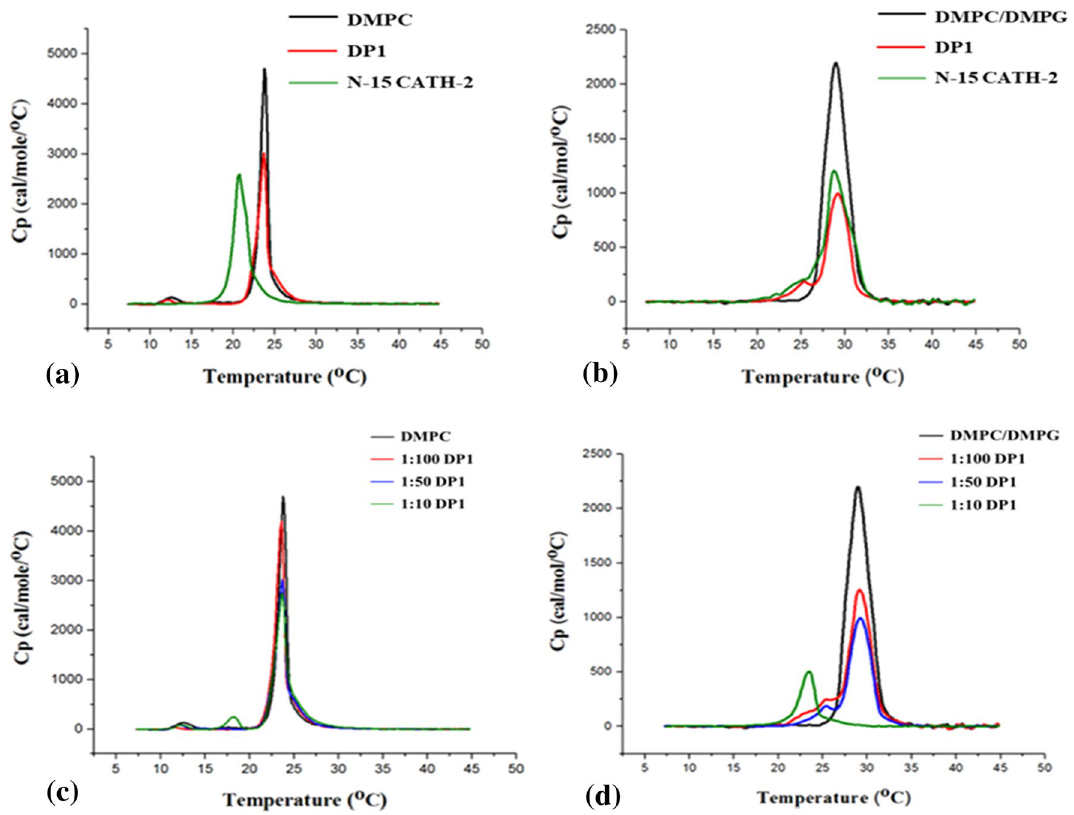
Figure 4. DSC heating thermograms for DMPC ( a ) and DMPC/DMPG ( b ) multilamellar vesicles with and without peptides. Scans were acquired at peptide/lipid molar ratio of 1:50. thermograms of DP1 with DMPC ( c ) and DMPC/DMPG ( d ) multilamellar vesicles at different peptide:lipid molar